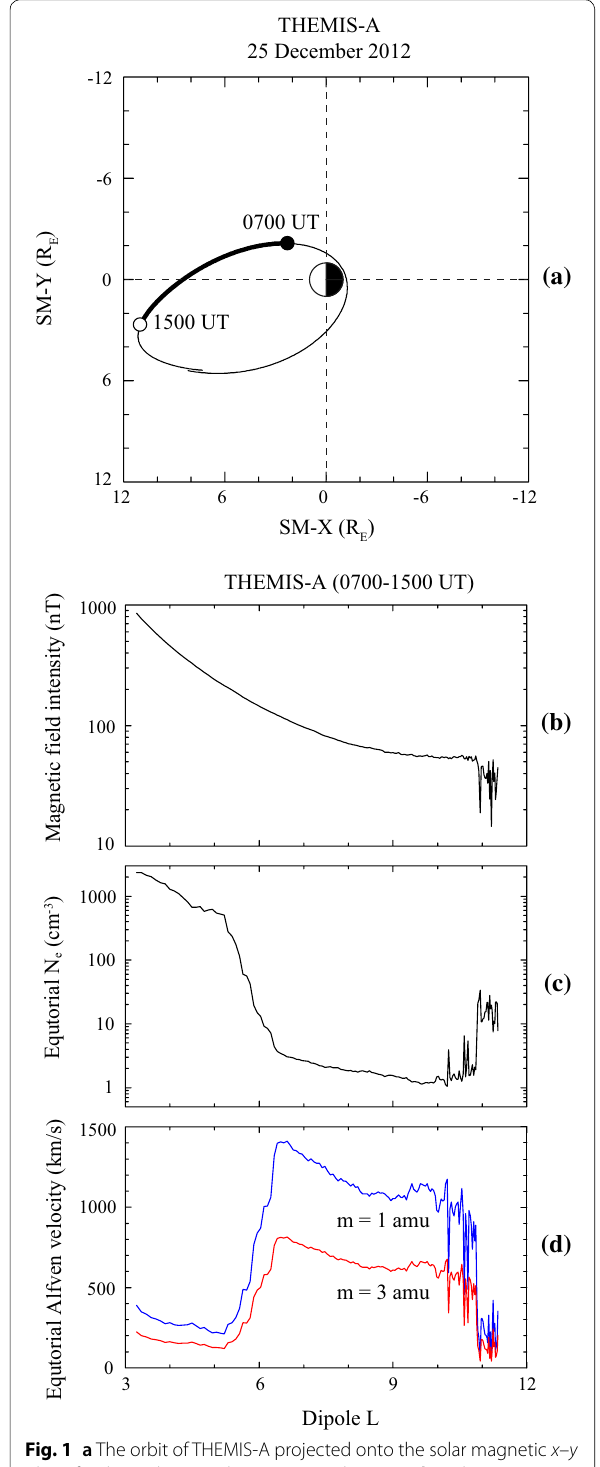
Fig. 1 a The orbit of THEMIS‑A projected onto the solar magnetic x – y plane for the 24‑h interval on 25 December 2012. b , c The magnetic field intensity and electron density as a function of L for the interval of 0700–1500 UT. d Equatorial Alfvén velocity using Eq. (1) with m amu (blue) and m 3 amu (red) near the magnetic =